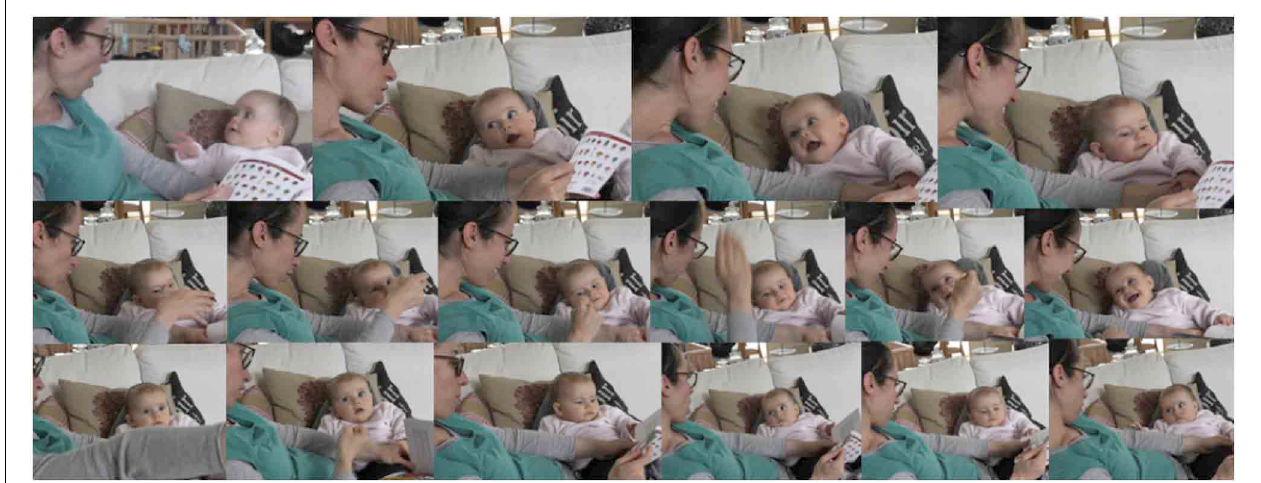
succession and hand in hand with the mother’s tone of voice and movement when narrating the story, the infant moves from surprise, amazement, to amusement, and from being staggered to concern and